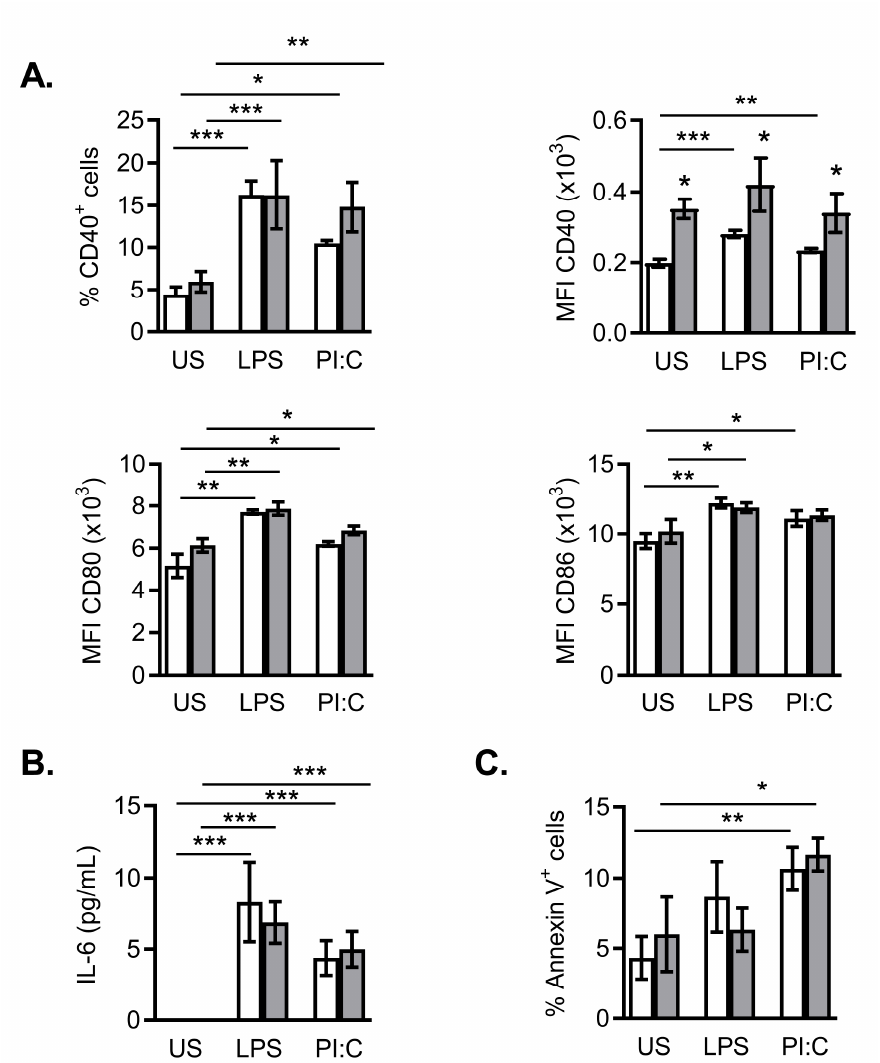
Figure 8. E ff ect of NanoMBGs in markers expression, IL-6 production and apoptosis in DC2.4 cells. ( A ) Expression (percentage of positive cells and median of fluorescence intensity, MFI) of di ff erent surface markers (CD40, CD80 or CD86) in DC2.4 cells, after 24 h of culture in the presence (grey bars) or absence (white bars) of NanoMBGs and di ff erent stimuli (LPS or Poly I:C). ( B ) IL-6 production measured by ELISA in culture supernatants of DC2.4 cells treated as in ( A ). ( C ) Spontaneous apoptosis in DC2.4 cells treated as in ( A ), measured by Annexin V assay. Data (mean ± SEM) from one representative experiment out of three, each with triplicates, are shown. Asterisks indicate significant di ff erence between the indicated bars (activated vs. non-activated cells compared) or adjacent bars (plus vs. minus nanomaterial added to the cultures). * p < 0.05; ** p < 0.01; *** p < 0.001.